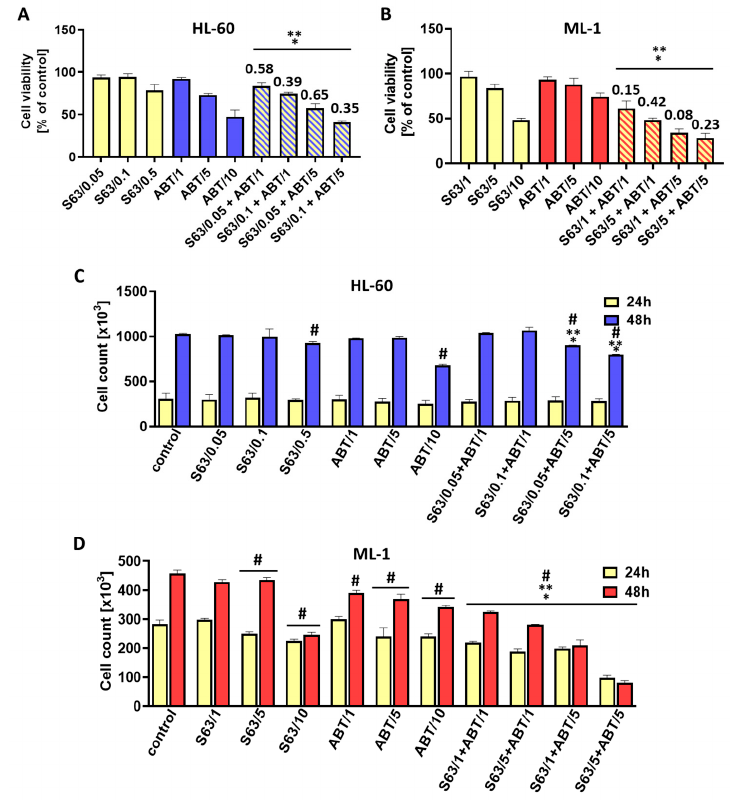
Figure 2. Effects of S63845 (S63) and ABT-737 (ABT) given as single agent or in combination on the viability and count of AML cells. Using PrestoBlue assay, the cell viability of HL-60 ( A ) and ML-1 ( B ) cells was determined at 48 h. The synergism between the tested agents was determined by the combination index (CI) analysis at a non-constant ratio. The CI values, generated using the Com- puSyn software according to the Chou–Talalay method, are given in graph A and B. Using the Coul- ter method, the HL-60 ( C ) and ML-1 ( D ) cell count analyses were performed at 24 h and 48 h after application of the tested agents. Designations 0.05, 0.1, 0.5, 1, 5 and 10 indicate the agent concentra- tions (µM). Three independent experiments were performed in triplicate ( A , B ) or duplicate ( C , D ). Values are reported as the means ± SD. Values signi fi cantly di ff erent ( p ˂ 0.05) according to one-way ANOVA are designated by * and ** compared to, respectively, S63845 or ABT-737—single treated group; # compared to the corresponding control. The cytotoxicity of S63845 and ABT-737 against AML cells was further explored by Coulter counter measurements indicative of cell number. A concentration-dependent de- crease in leukemia cell count was observed 24 h and 48 h after application of the BCL-2 inhibitors alone (Figure 2C,D). However, the combination of S63845 and ABT-737 resulted in a further reduction in cell count as compared to the values obtained with each of these compounds alone. Additionally, the method revealed that the combination of the two BCL-2 inhibitors was more potent in reducing the cell count of ML-1 cells than those of HL-60 (Figure 2C,D). Based on the data acquired from the analysis of leukemic cell viabil- ity and count, S63845 at a concentration of 0.1 µM for HL-60 cells and 5 µM for ML-1 cells was chosen for further analyses. In the case of ABT-737, a concentration of 5 µM was used for both AML cell lines.